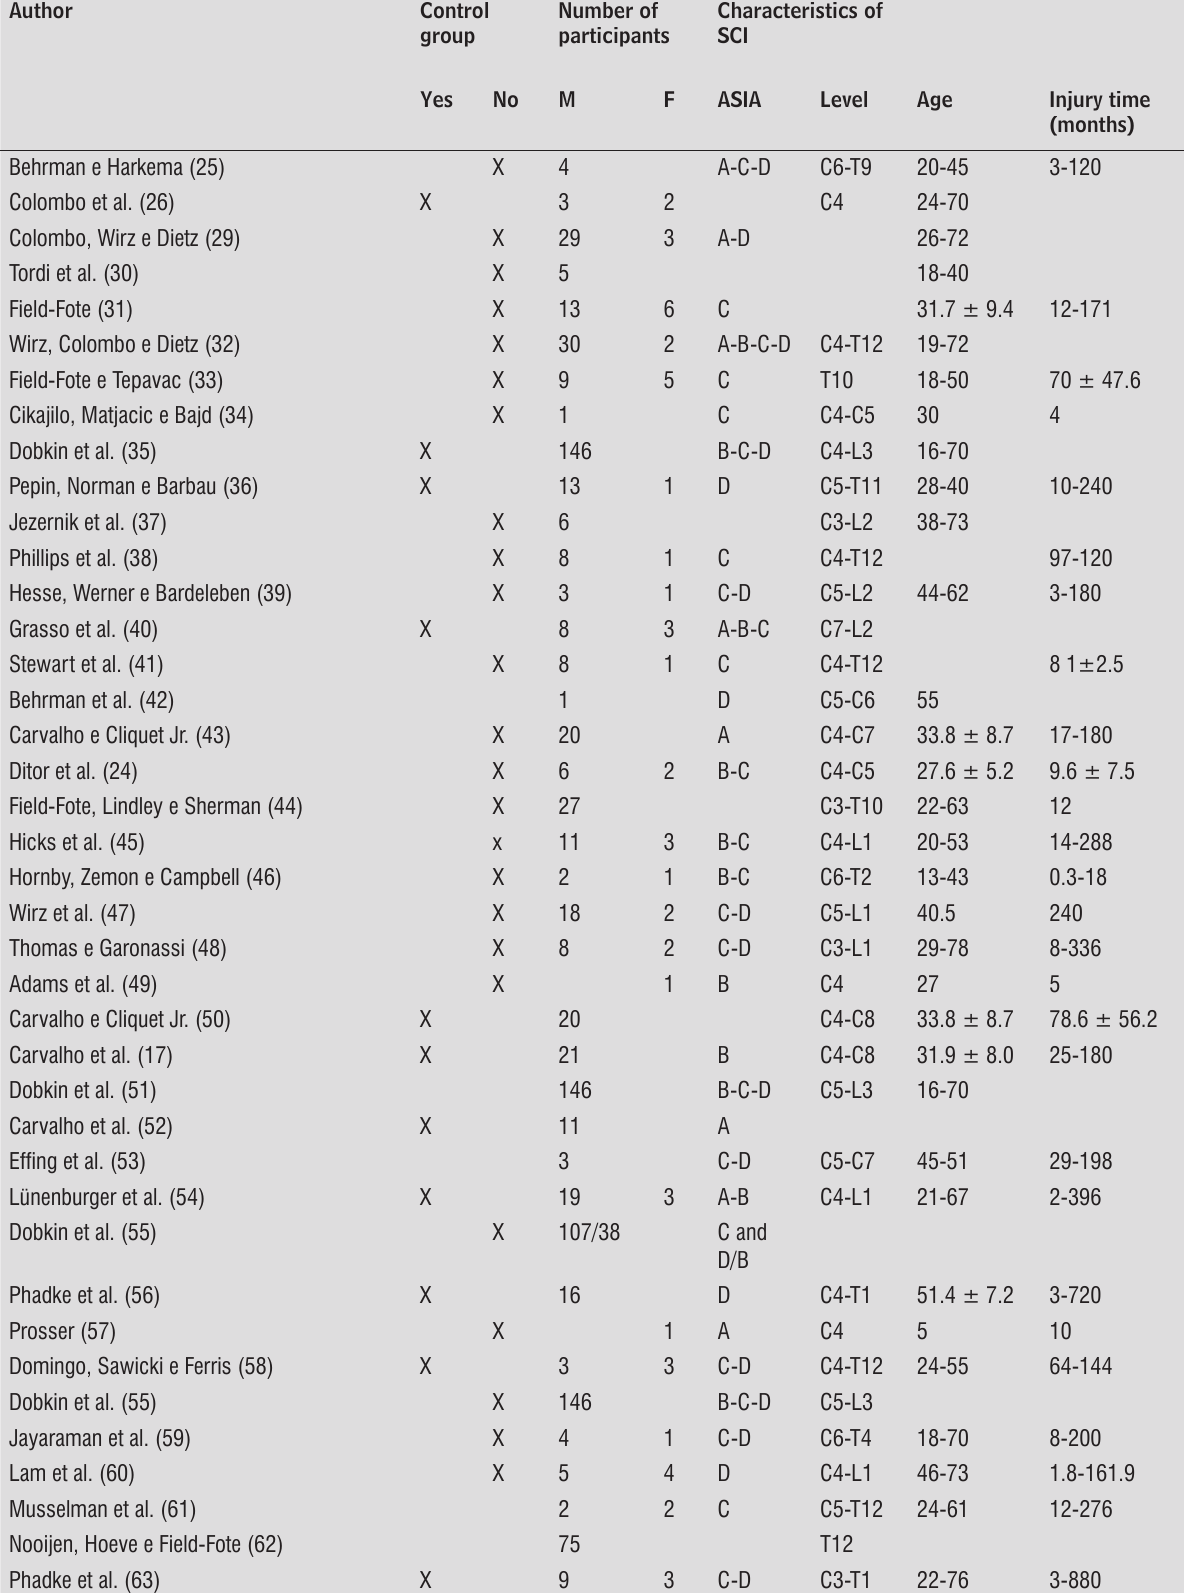
Table 1 - Sample and sampling classification used in researches on